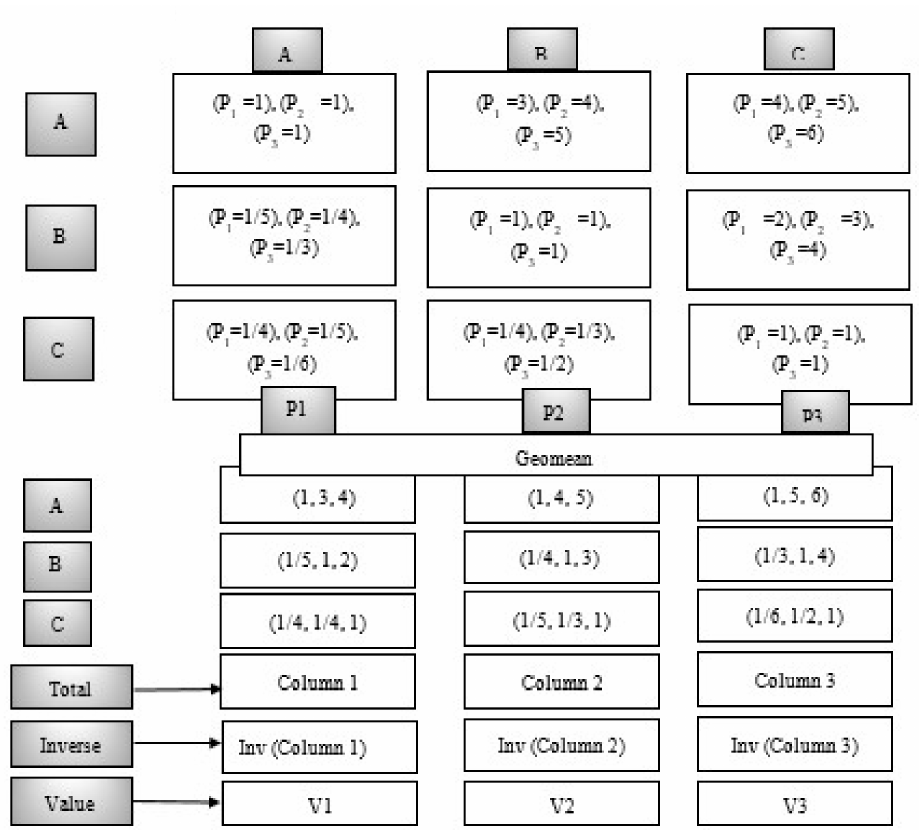
Figure A2. An illustration for individual criterion geometric mean